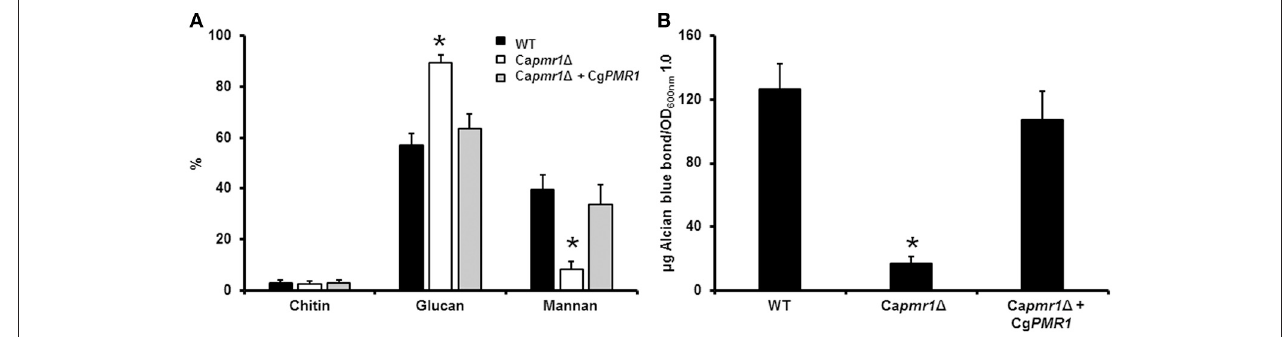
FIGURE 1 | Cg PMR1 is the functional ortholog of Ca PMR1 . Cg PMR1 was expressed in the C. albicans pmr1 1 null mutant, as described in Experimental procedures, and the cell wall was isolated and analyzed by High-Performance Anion-Exchange Chromatography with Pulsed Amperometric Detection to assess the carbohydrate content (A) . In addition, the ability of cells to bind Alcian blue was analyzed (B) . * P < 0.05. Strains used are: NGY152 (WT), Ca pmr1 1 (NGY355), Ca pmr1 1 + Cg PMR1 (HMY186).